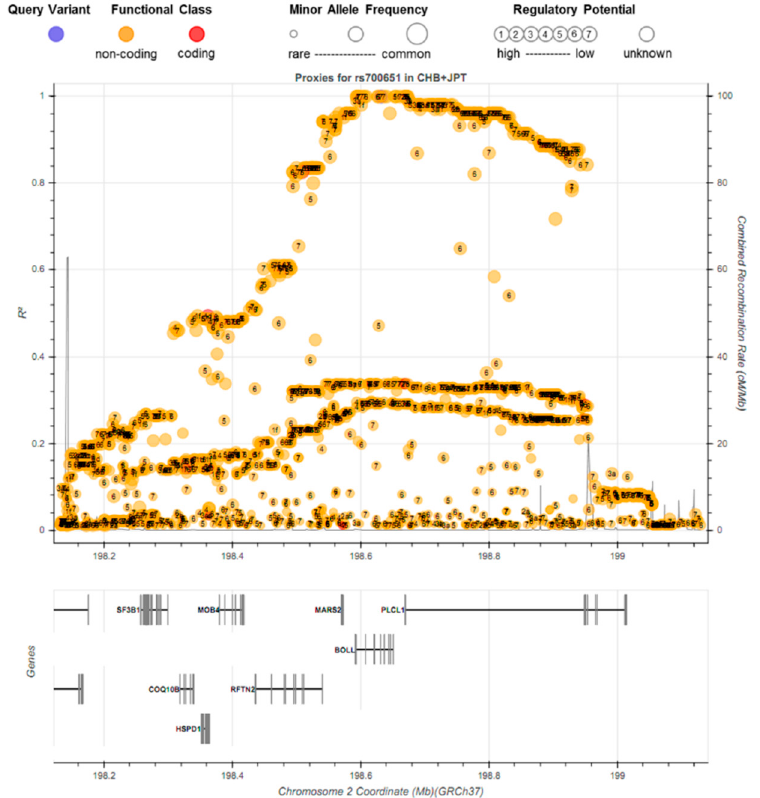
Figure 3. Regional visualization in pairwise linkage disequilibrium (LD, r 2 ), functional annotation, RegulomeDB scores, and minor allele frequency for 1599 variants within the rs700651 region variant position ± 500 kbp in East-Asian populations (JPT + CHB of 1000 Genome Phase 3 reference panel).